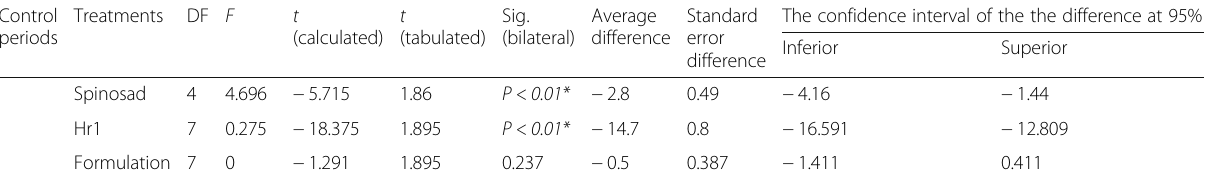
Table 4 Student test for independent samples ( P ≤ 0.05, n = 5) to compare the averages of the different treatments before and after rain simulation (Continued) Control Treatments DF F The confidence interval of the the difference at periods